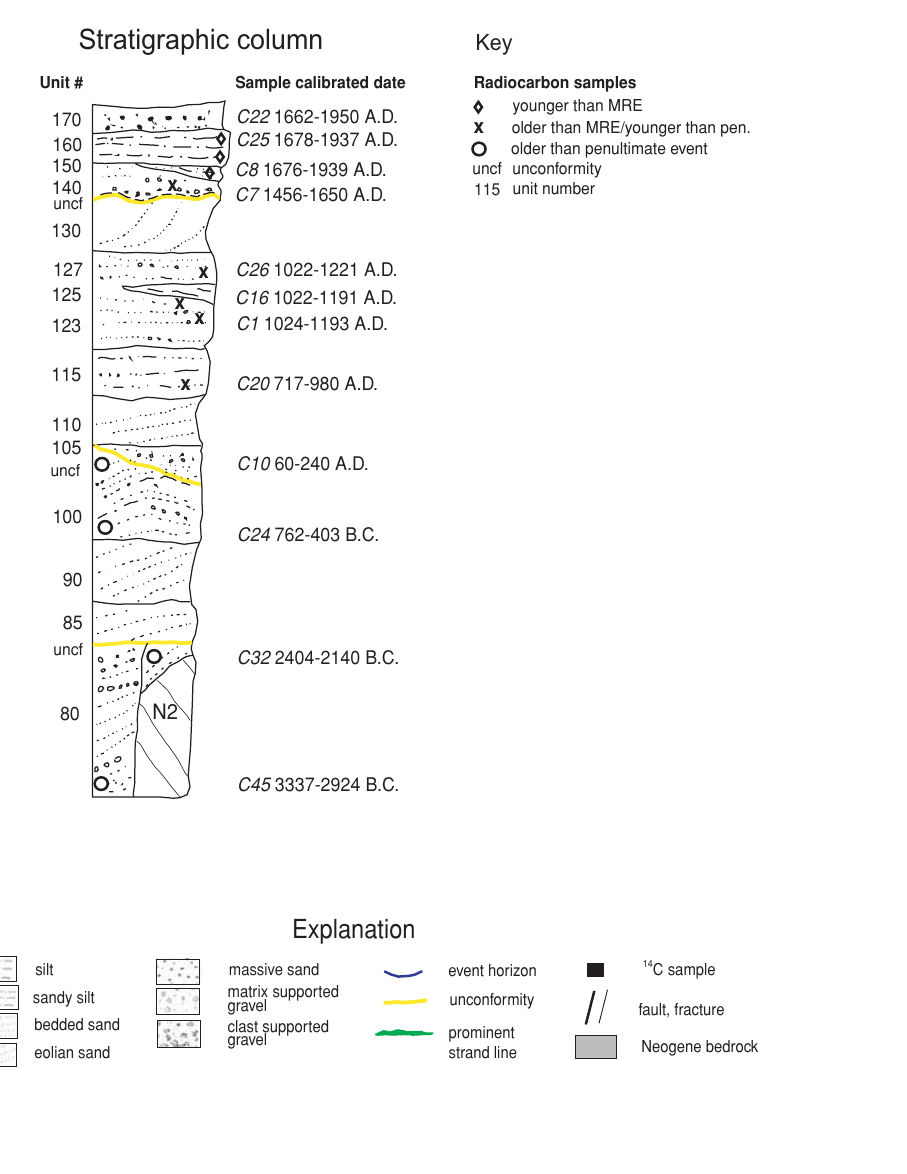
Fig. 9. Trench logs for the Camel paleoseismic site at 198 km. Most faults terminate at the upper blue line, the event horizon for the last earthquake at this site. The penultimate earthquake is identified by upward fault ter- minations and folded bedding overlain by continuous strata, which is marked by the lower blue line. This penul- timate event horizon coincides with a small unconformity (yellow line) identified by different levels of indura- tion and an irregular contact with cm deep rills in places. Stratigraphic column of Camel trench at lower left shows relative unit thickness, unit number, major unconformities, and stratigraphic location of radiocarbon sam- ples. See discussion in text for further interpretation and timing constraints on earthquakes seen in this